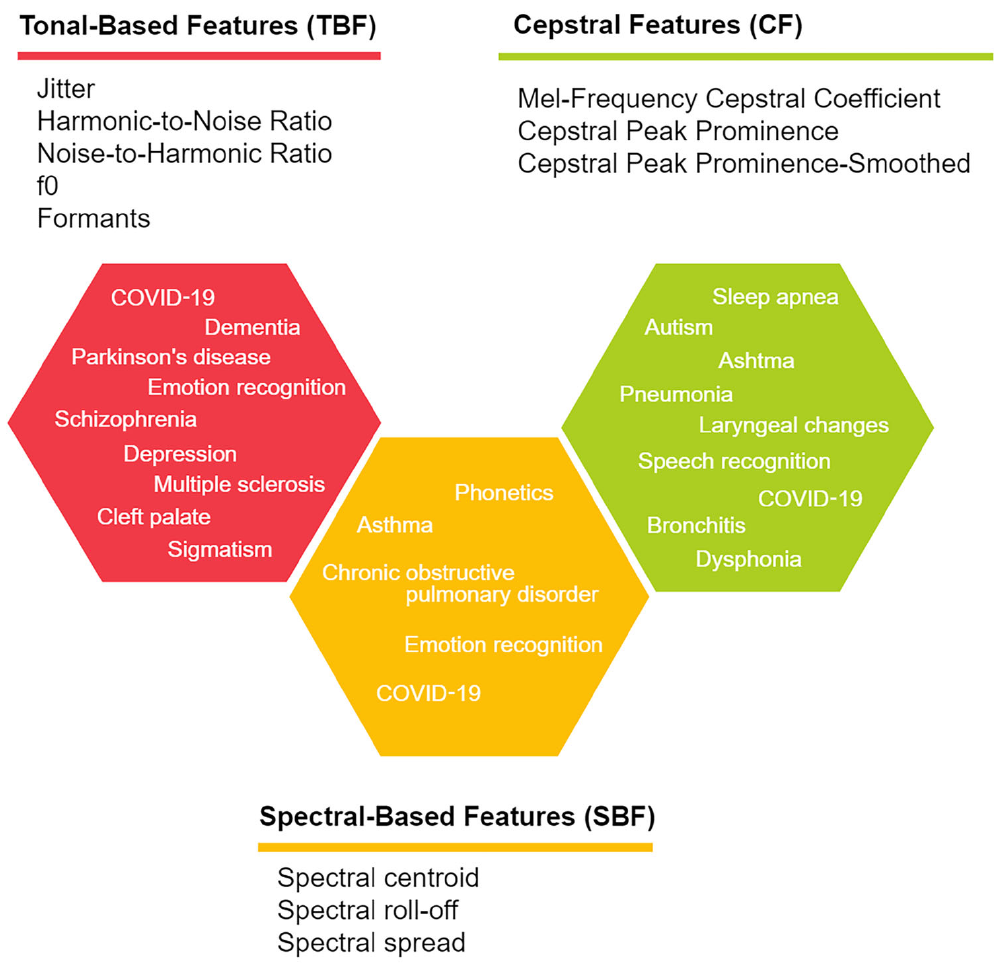
Figure 6. Commonly used acoustic features in the frequency domain from the revised literature. The main applications for each group of features are shown inside the hexagons.